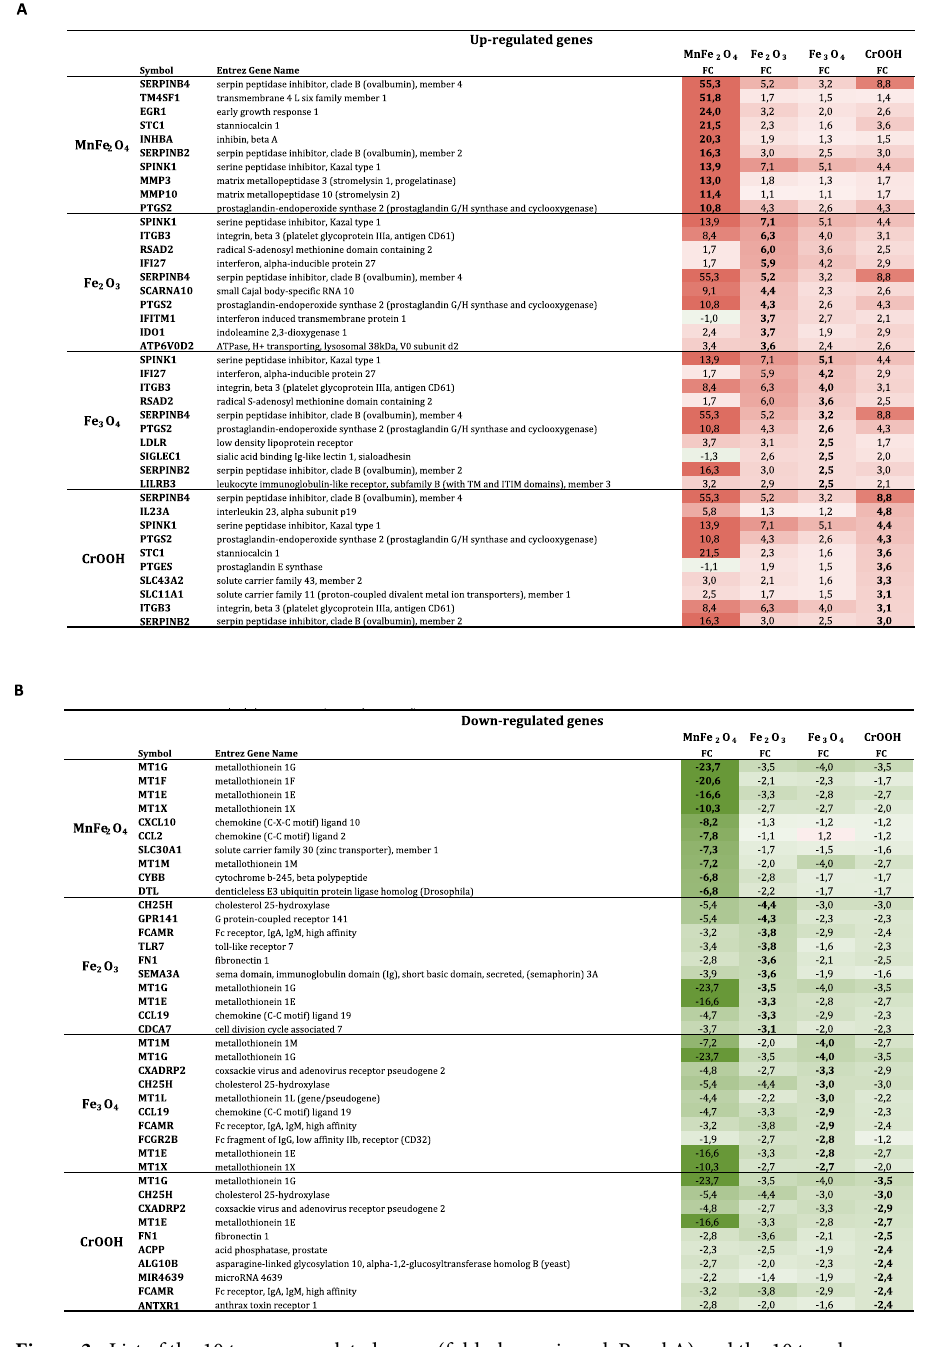
Figure 3. List of the 10 top up-regulated genes (fold-change in red, Panel A) and the 10 top down-regulated genes (fold-change in green, Panel B) by nanoparticle. Abbreviations as in Fig.